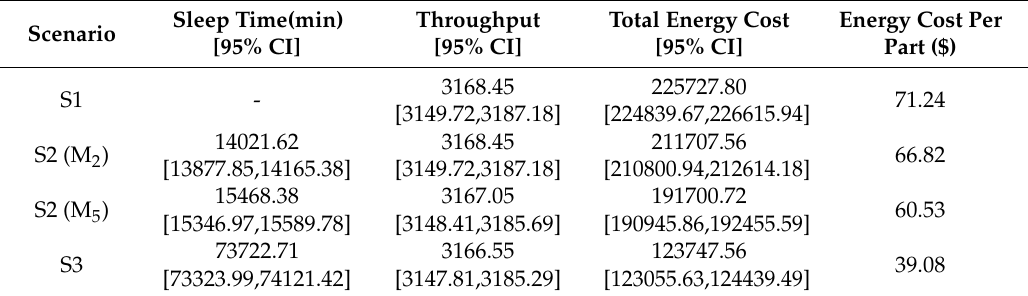
Table 5. Comparison of system performances in three